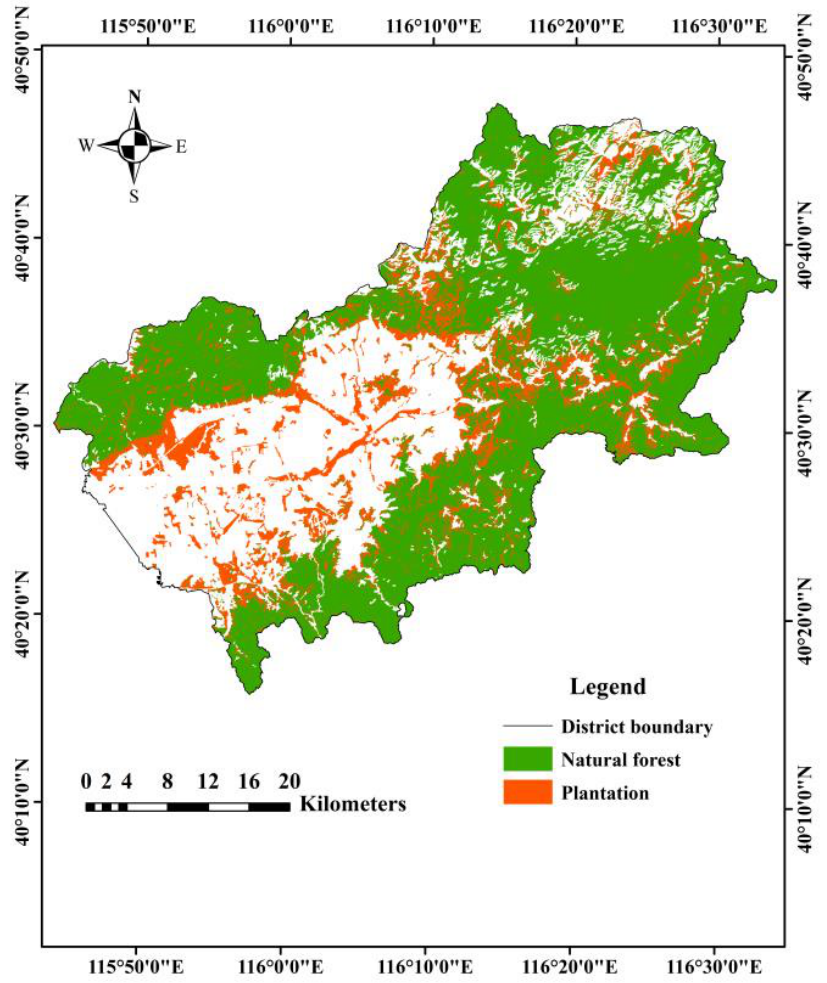
Figure 9. Two-forest type map of Yanqing based on random forest model.